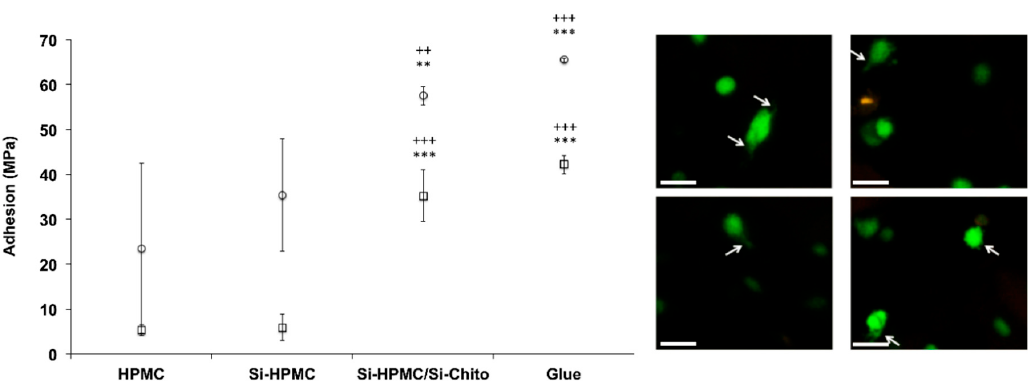
Figure 2. ( A ) Graph representing the injectability (normal force required to eject the solution out of the syringe with a needle (square)) and the viscosity of the silanized chitosan and silanized HPMC mixed solution (diamond). ( B ) Graph representing the gel point (normal force required to eject the solution out of the syringe with a needle (square) and without a needle. ( C ) Graph representing the combined evolution of the storage modulus (G ′ , triangle) and the breaking strain ( σ , square) with an increasing concentration of Si-chitosan. *** p < 0.001 compared to the 2/0 condition . + p < 0.05 compared to the 2/0.66 condition. +++ p < 0.001 compared to the 2/0.66 condition. ### p < 0.001 compared to the 2/1.33 condition.